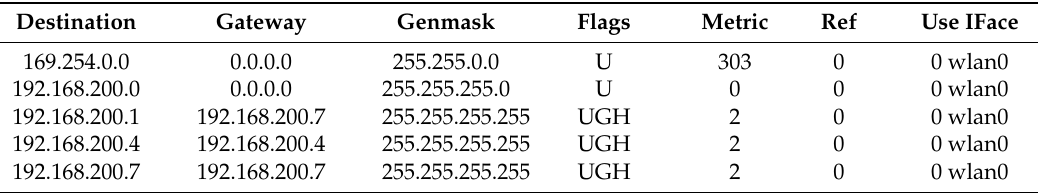
Table 6. Most habitual kernel IP routing table for